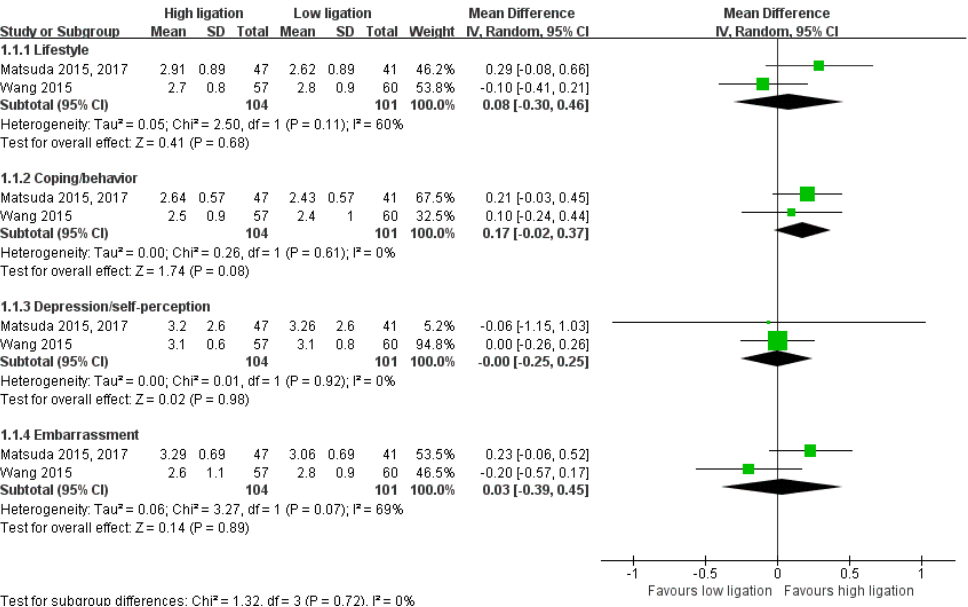
Figure 3. Forest plot of defecatory dysfunction assessed by each domain of the fecal incontinence quality of life scale (short-term) .